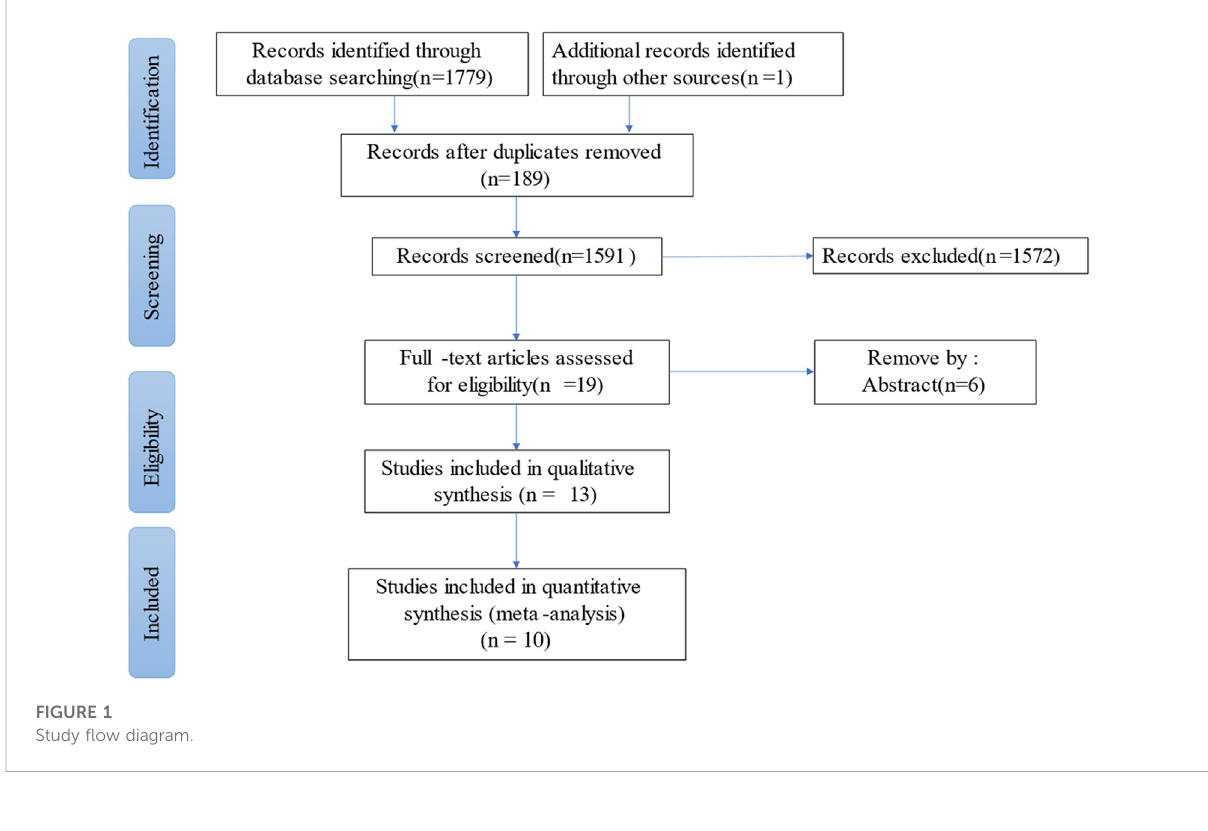
TABLE 1 Demographic information of the